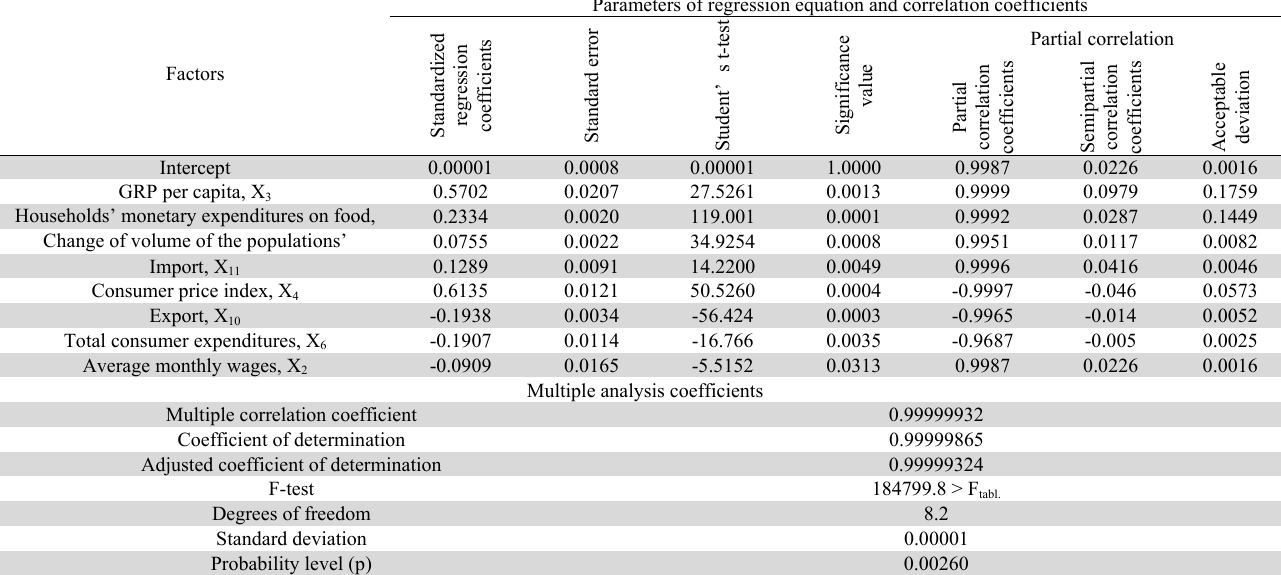
Results of the multiple regression of the dependence between the volume of sold food products in Chernivetska oblast and socio- economic factors